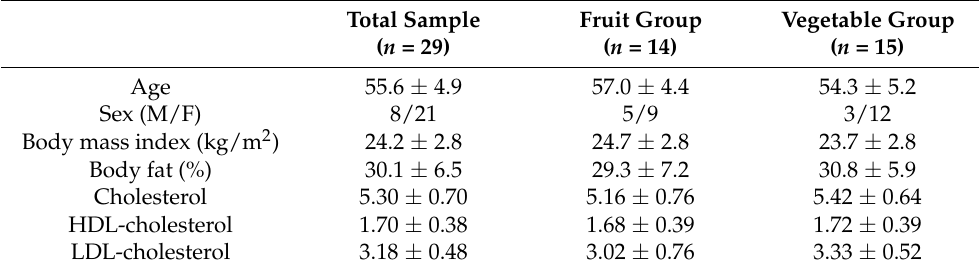
Table 1. Characteristics of the participants in the intervention study.